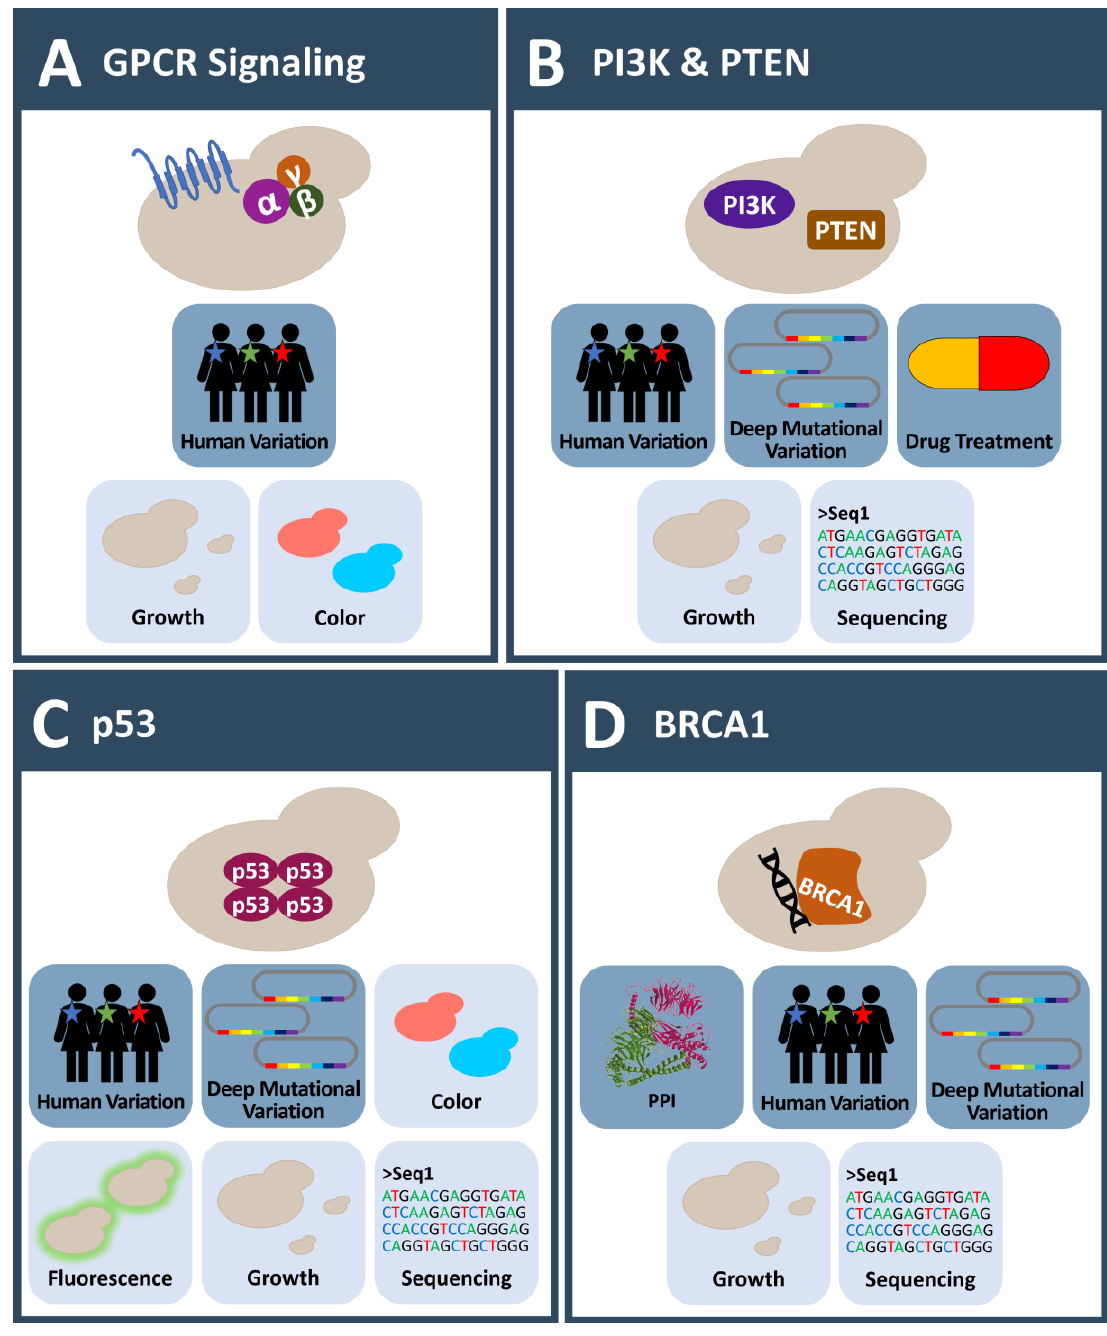
FIGURE 2: Yeast systems to investigate human mutation in cancer proteins. (A) GPCR signaling plays an outstanding role in humans, yet only two GPCR related pathways are present in yeast. These pathways can be engineered to investigate human regulators of GPCR signaling and mutations in these proteins in yeast. (B) Several aspects of the human PI3K-PTEN-AKT signaling pathway are studied in yeast in the absence of endogenous PI3K activity. Membrane targeting of PI3K in yeast causes a growth phenotype and thus enables the testing of inhibitors. Muta- tions in PI3K or PTEN frequently found in developing cancers are functionally assessed in yeast. (C) Yeast is missing a p53/TP53 homologue. Expression of the human tumor suppressor p53 results in growth defects in yeast. A plethora of assays to investigate the protein function are established in yeast. This allows observing the influence of human variation and the effects of p53 cancer mutations in this system. (D) Though absent in yeast, expression of the BRCA1 tumor suppressor impacts HR activity of yeast resulting in various phenotypes. This is the basis for the investigation of BRCA1 mutations. Deep mutational scanning of BRCA1 has been applied to comprehensively investigate the effects of amino acid substitutions on protein E3 ligase activity and PPI. (A-D) Icons with dark blue background: observable; Icons with light blue background: readout; MS: mass spectrometry; PPI: